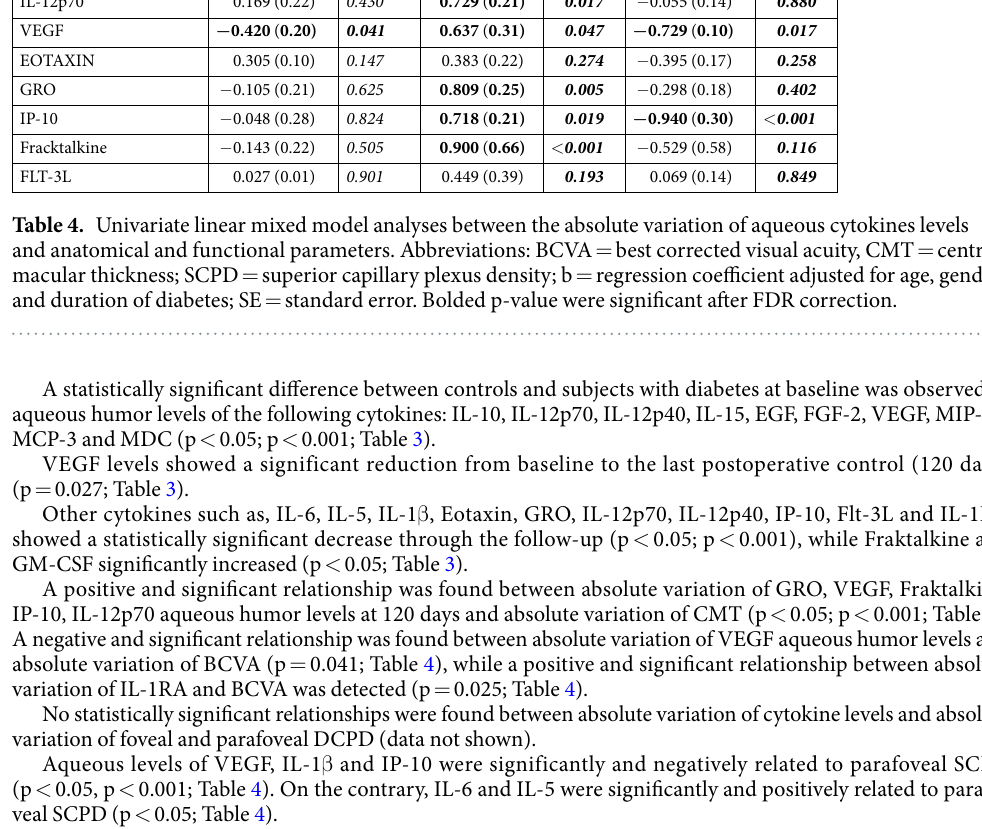
Absolute variation of anatomical and functional parameters BCVA (logMAR) CMT ( µ m) Parafoveal SCPD ( µ m) Absolute variation of cytokine levels (pg/mL)